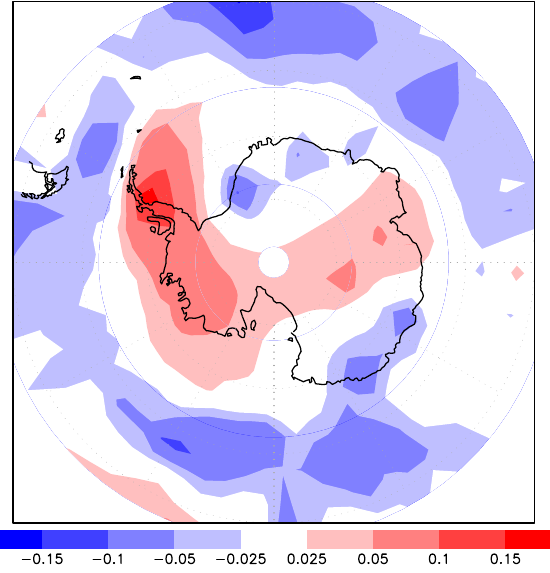
Figure 4. Surface air temperature trend (Kdecade − 1 ) over the pe- riod 1979–2010 calculated from the yearly averaged Had4Krig ver- sion 2.0.0 data